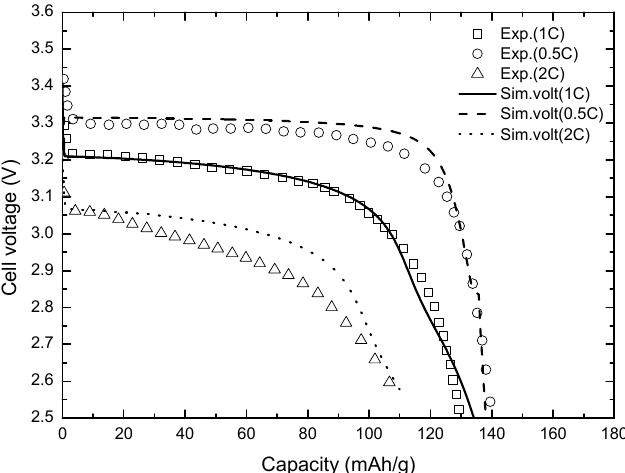
Figure 4. Comparison of the simulated (lines) and measured (symbols) discharge voltage curves at various C-rates. Only the positive electrode potential from the LIB full cell simulation results was plotted for comparison with the experimental data.